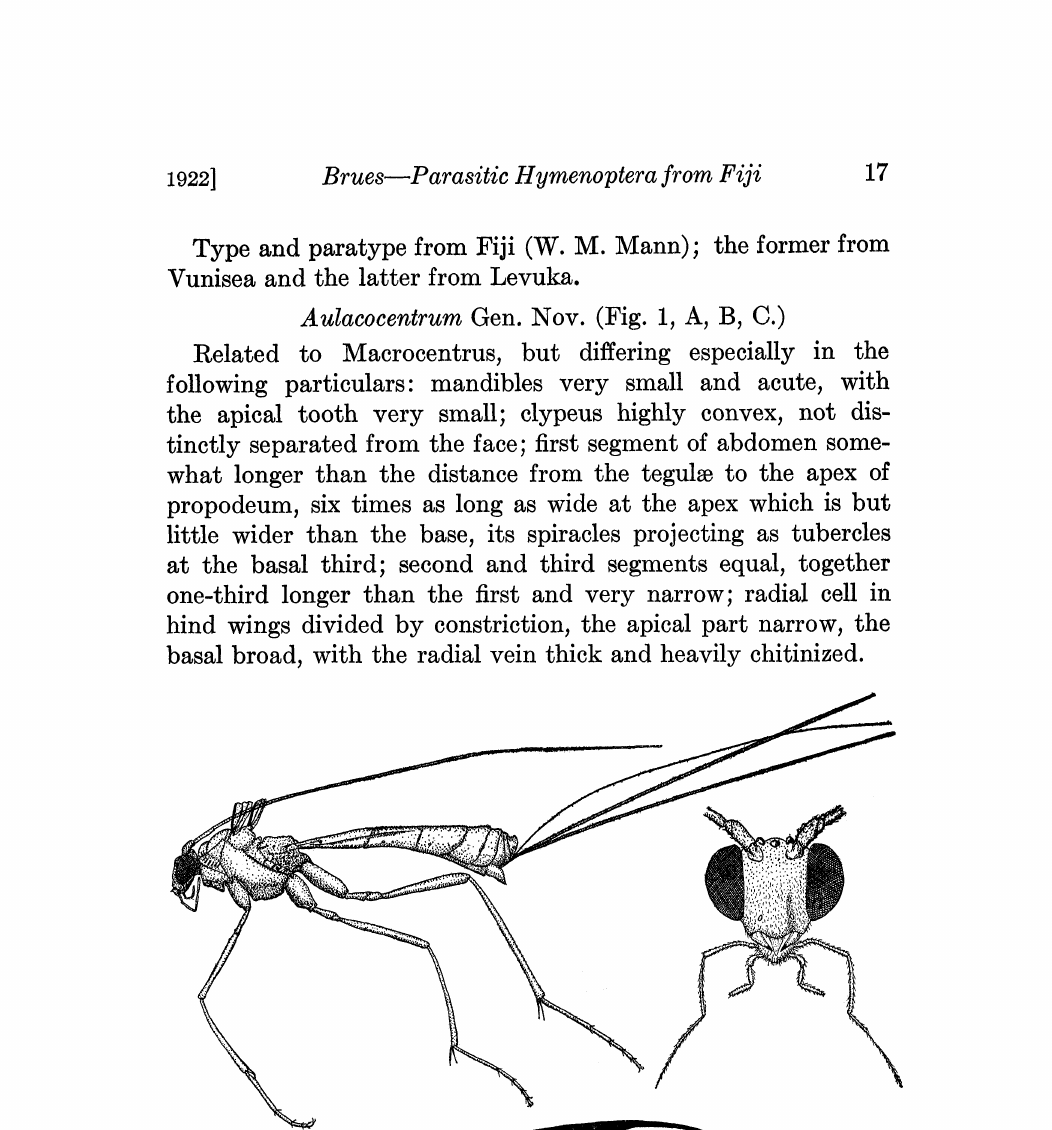
Fig. 1. Aulaoeentrum Pedicellatum sp. nov. Q profile view of body, front view head and